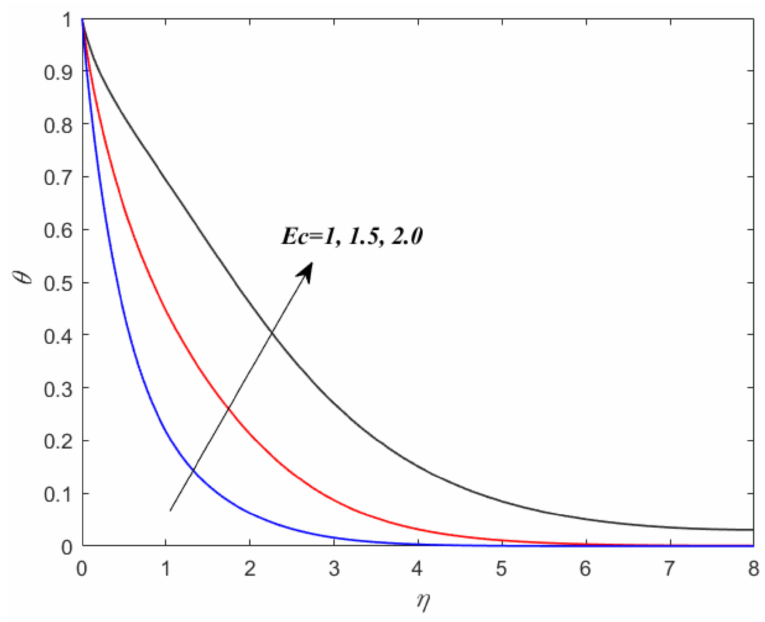
Figure 8. Various values of Eckert number ( Ec ) on temperature θ ( η ) .